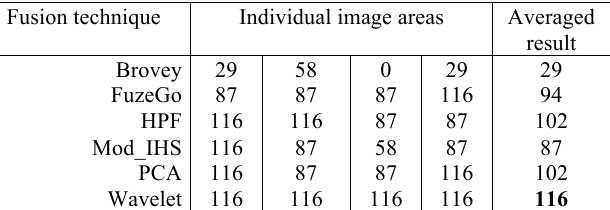
Table 3. Visual assessment of criterium colour preservation at local level. The maximum score reachable is 116 (Fries 2017).